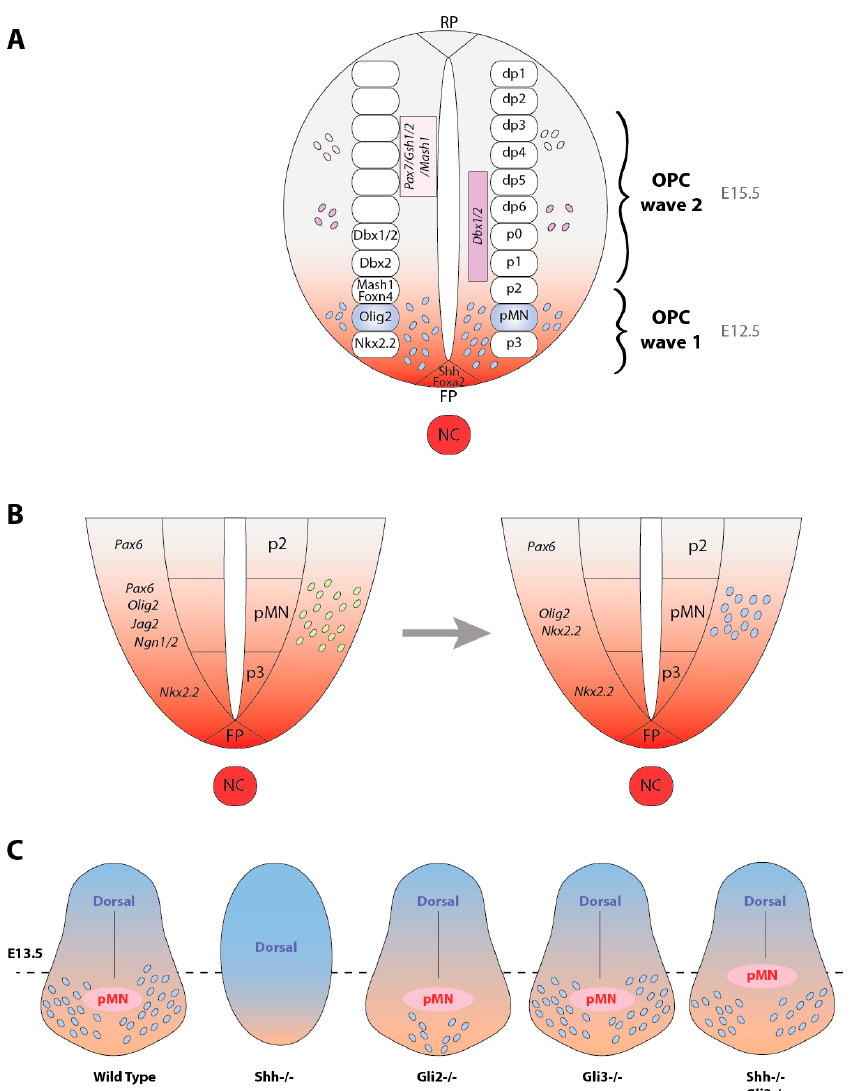
Figure 2. Hedgehog-dependent production of the OL lineage in the developing spinal cord. ( A ) Cross-sectional view of the neural tube indicating the production of the secreted Hedgehog proteins ( red ) from the notochord (NC) and the floorplate (FP). The roofplate (RF) secretes BMP and Wnt. Oligodendrocyte progenitor cells (OPCs) are produced as successive waves, which occur in mice at E12.5 and E15.5, respectively. The first wave arises from the pMN domain and the second one from progenitors expressing either Pax7/Gsh1/2/Mash1 or Dbx1/2. The ventral (p0–p3, pMN) and dorsal (dp1–6) neuroepithelial domains are indicated on the right side of the neural tube while the gene expression patterns for the different ventral progenitor domains are indicated on the left side; ( B ) Schemes of the ventral neural tube during Hedgehog-dependent MN ( left , in green ) and OL ( right , in blue ) generation from the pMN domain. At the time of OPC specification, Hedgehog signaling maintains Olig2 expression in the pMN domain whereas it promotes the dorsal extension and regression of the Nkx2.2 and Pax6 domains, respectively; ( C ) Schematized views of the neural tube in E13.5 wild-type or knockout mice indicating the distribution of OPCs derived from the pMN. OPCs ( blue ) have already invaded the ventral neural tube in the wild-type mouse. In the absence of Shh, no ventralization of the neural tube is observed and OPCs are completely absent. In the Gli2 mutant, the ventral production of OPCs is highly decreased while it is unaffected in the Gli3 mutant. Finally, the Gli3 mutation partially rescues the ventral oligodendrogenesis in the Shh mutant.